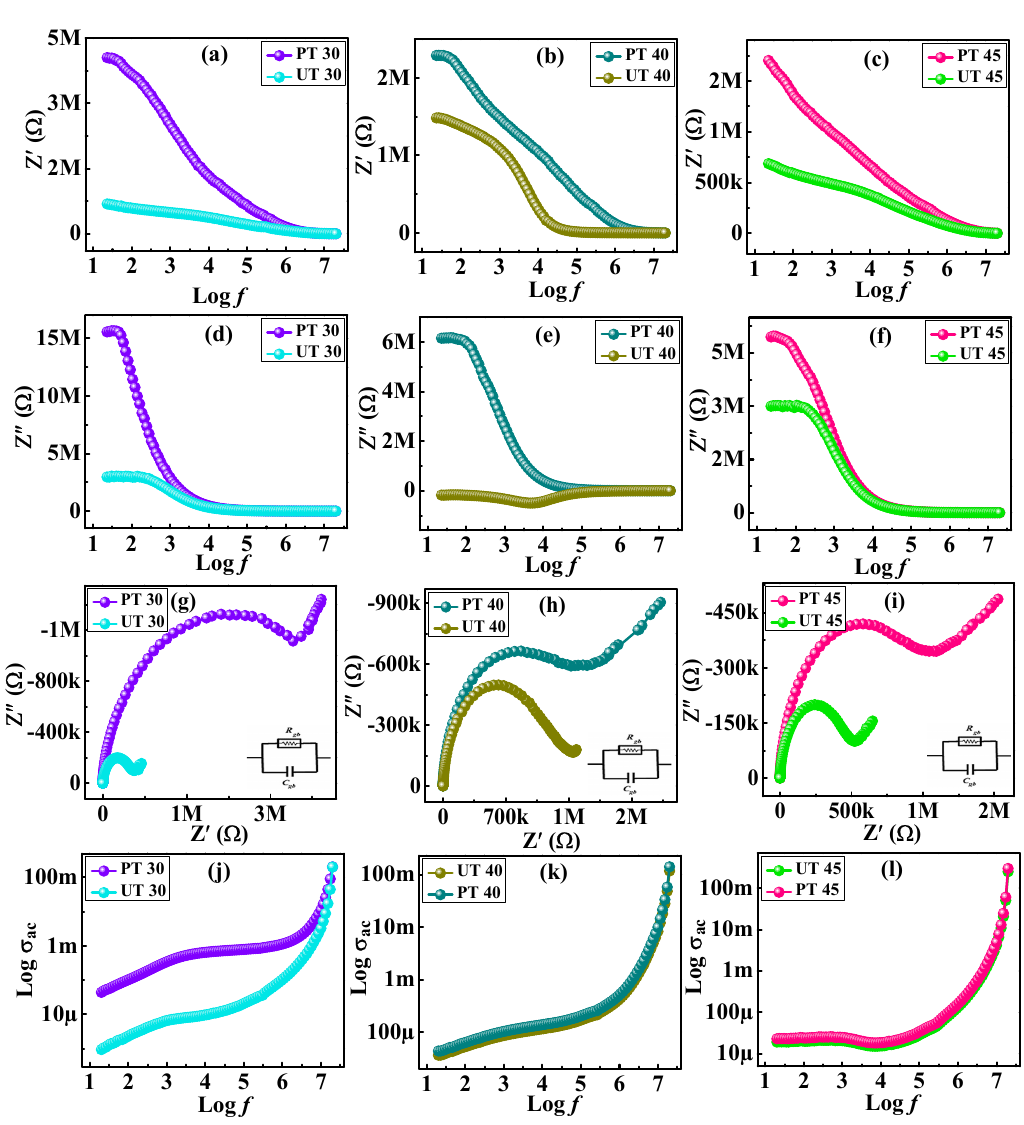
Figure 9. ( a – c ) Resistive and ( d – f ) reactive responses, ( g – i ) Nyquist plot, and ( j – l ) ac-conductivity for Figure 9. ( a–c ) Resistive and ( d−f ) reactive responses, ( g−i ) Nyquist plot, and ( j−l ) ac-conductivity for plasma treated and untreated samples. plasma treated and untreated